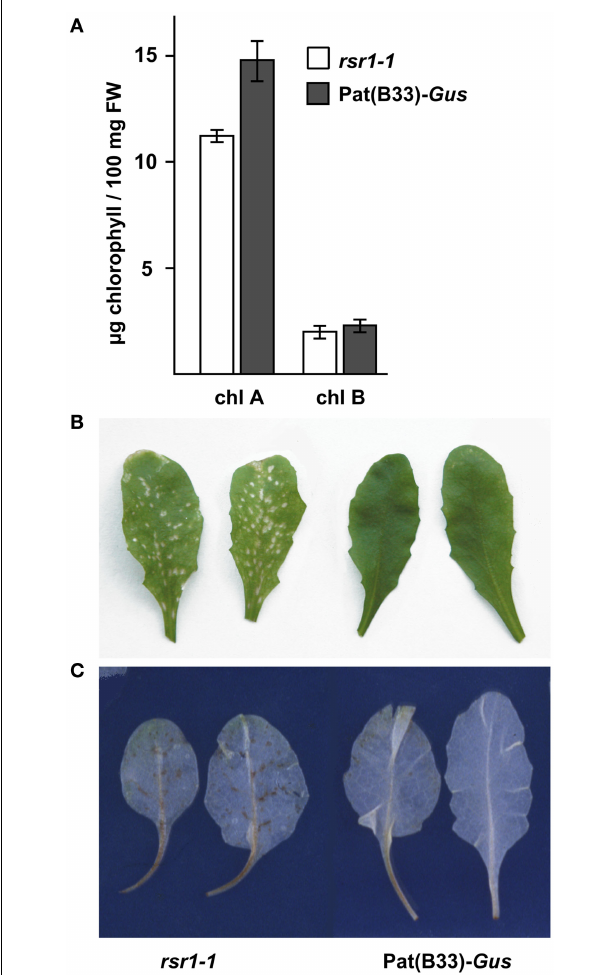
FIGURE 1 | rsr1-1 has reduced chlorophyll and forms spontaneous lesions. (A) Chlorophyll was extracted from 30-day-old soil grown plants. Chlorophyll A and B content was significantly reduced in the rsr1-1 mutant compared to the parental line Pat(B33)- Gus .Values presented are the mean ± SD from 10 plants. (B) Under long-day conditions in the greenhouse, rsr1-1 mutants displayed spontaneous lesion formation on all leaves. (C) Infiltration with 3,3 (cid:2) -diaminobenzidine demonstrated ROS accumulation in lesions of rsr1-1 leaves.